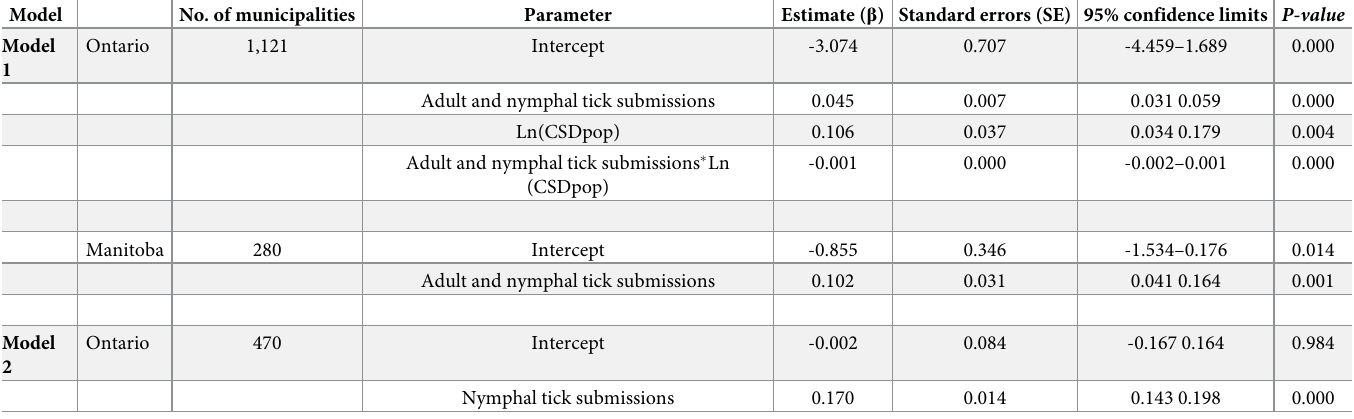
Table 2. Negative binomial generalized estimating equation models testing for the influence of the number of I . scapularis tick submissions on the occurrence of human Lyme disease cases; adult and nymphal I . scapularis submissions (Model 1) and nymphal I . scapularis submissions (Model 2) detected by the passive tick sur- veillance program in Ontario and